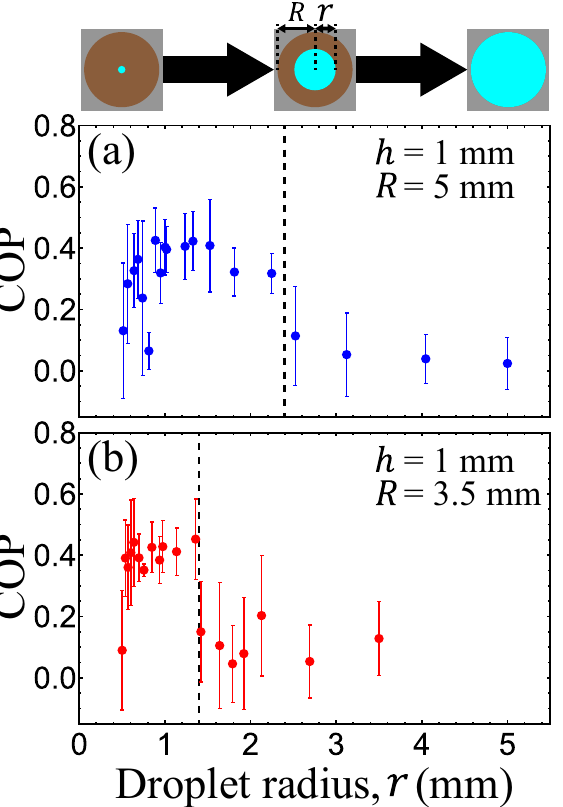
Figure 2. The intradroplet circulatory flows depended on the dimensions of the droplets and oil. ( a ) Droplets immersed in an oil of radius R = 5 mm developed circulatory flows when their radii were r ≲ 2.4 mm (black dashed line). Enlarging the droplets above this limit suppressed the formation of circulatory flows. ( b ) However, such critical radius was altered when the oil was shrunken to a radius of R = 3.5 mm. In this case, the circulation transition was shifted to r ≈ 1.4 mm (black dashed line). The shift implies that the intradroplet circulatory flows were affected by the oil dimensions and by the droplet radii. Each error bar represents the standard deviation of the time-averaged circulation order parameter